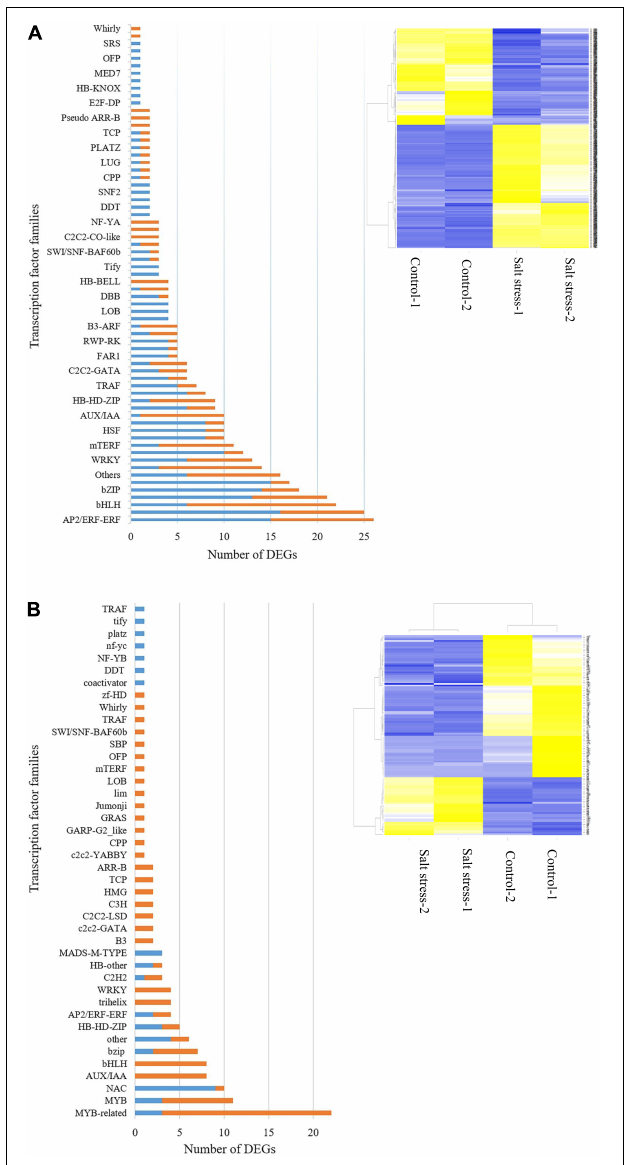
FIGURE 6 | Transcription factors (TFs) differential expressed. Number of up (blue bar)- or down (orange bar)-regulated gene in transcription factors (TFs) expressed (left) and heat map of expression changes in differentially expressed genes (DEGs) under control and salt -stress conditions (right) in the (A) salt-tolerant genotype and (B) salt-sensitive cultivar